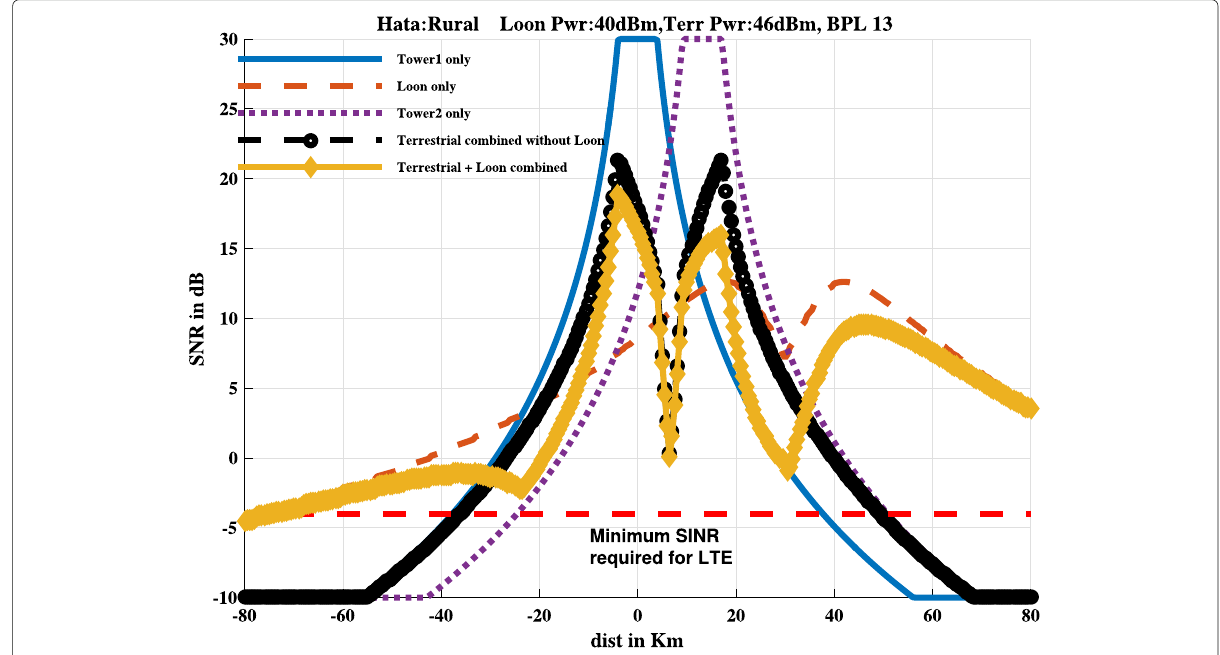
Fig. 6 Expected indoor SINR with two rural terrestrial towers and a Loon